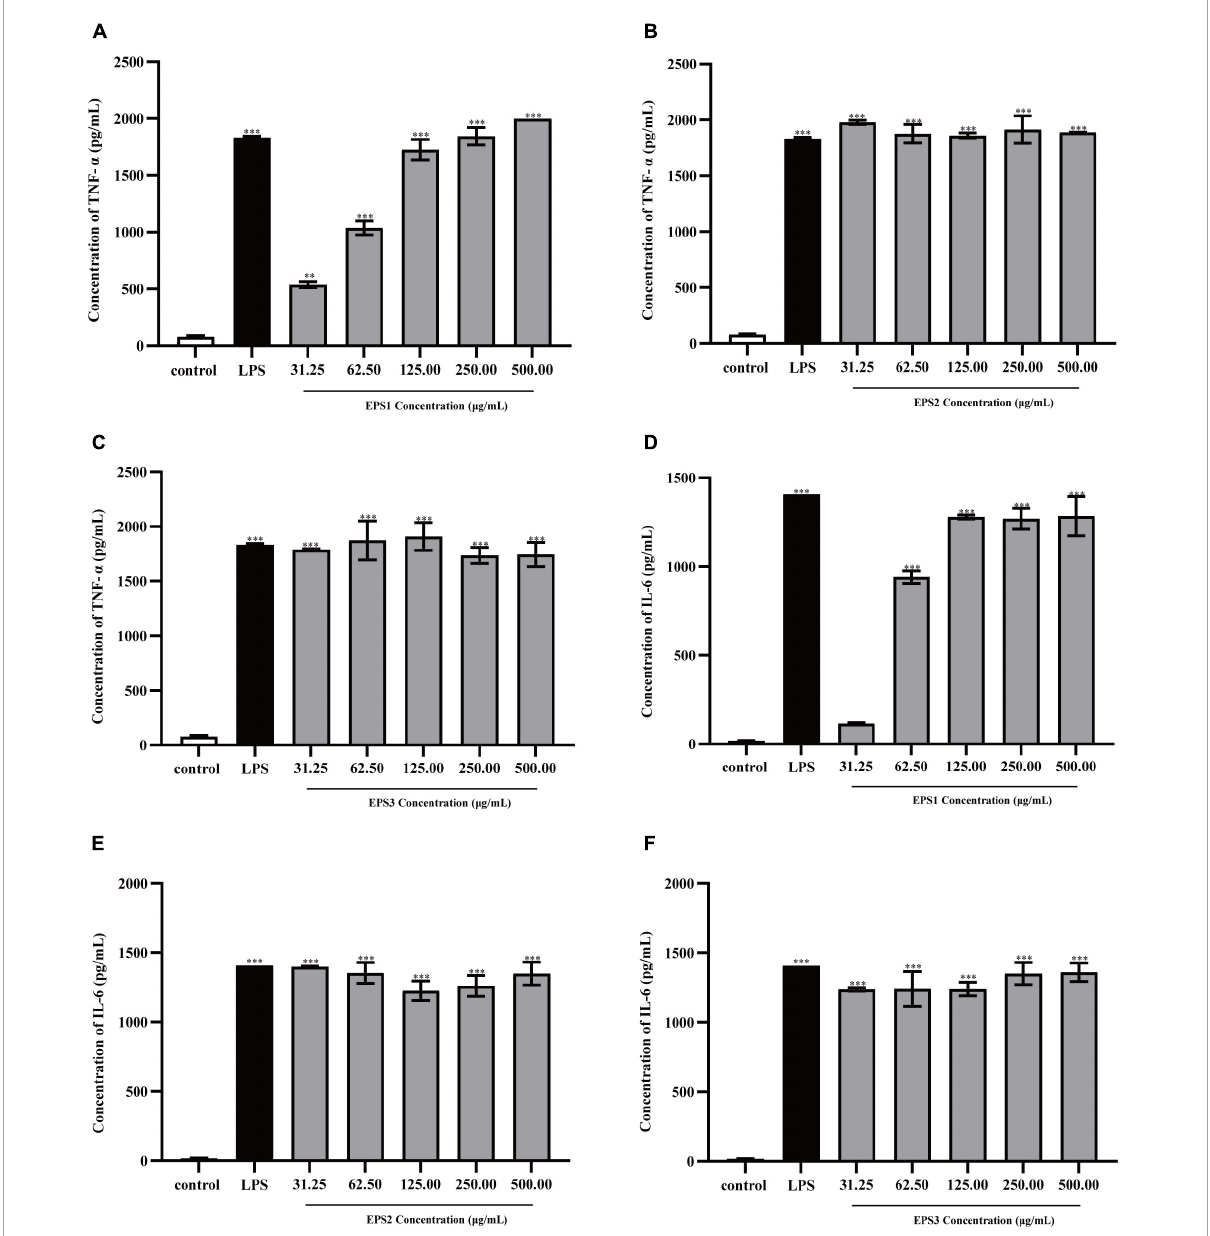
FIGURE9 Production of the cytokines TNF- α by Ana-1 cells treated with purified (A) EPS1, (B) EPS2, and (C) EPS3. IL-6 production by Ana-1 cells treated with (D) EPS1, (E) EPS2, and (F) EPS3. Data are expressed as the mean ± standard error of the mean ( n = 6). ∗∗ P < 0.01, ∗∗∗ P < 0.001, compared to untreated control. Error bars represent ±